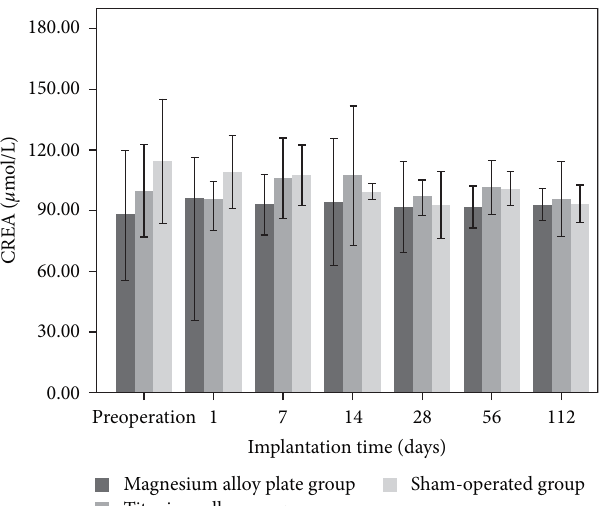
F IGURE 4: Results of CREA levels before and after surgery in each group ( ∗ P < 0 : 05).